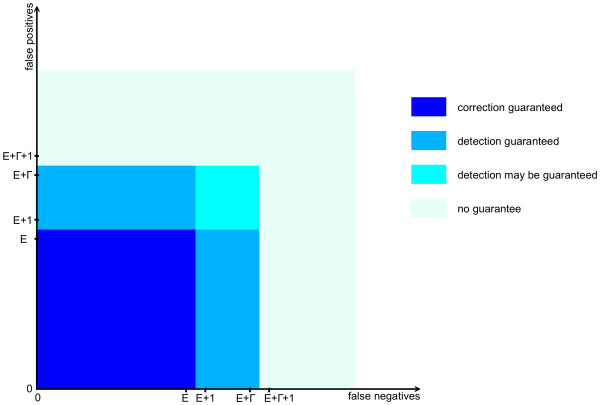
Guaranteed error correction and detection properties of STD. An experimenter, expecting up to t positives and E errors, chooses a satisfactory prime number q and builds the set of pools STD(n; q; t·Γ+2·E+1), as specified in corollary 2. Recall that n is the total number of variables and Γ is the compression power, i.e. the smallest γ such that qγ+1 ≥ n. This figure summarizes the behavior of these pools when the actual number of errors exceeds E, and distinguishes between the two types of errors: false positives and false negatives. In the dark blue region, all errors are detected and corrected. In the intermediate blue rectangles, correction is not guaranteed but detection is: in an unfavorable conformation of positives and errors, correction of all errors may fail, but this failure cannot go unnoticed, and the user can therefore plan additional experiments. In the cyan square, detection is usually also guaranteed, except if E is very small (E < 2·Γ-1): in this case, the line y = 3·E+1-x splits the square in two, and detection is only guaranteed in the bottom left portion, where the total number of errors is at most 3·E+1. Finally, in the outer pale cyan zone, no guarantee is provided.